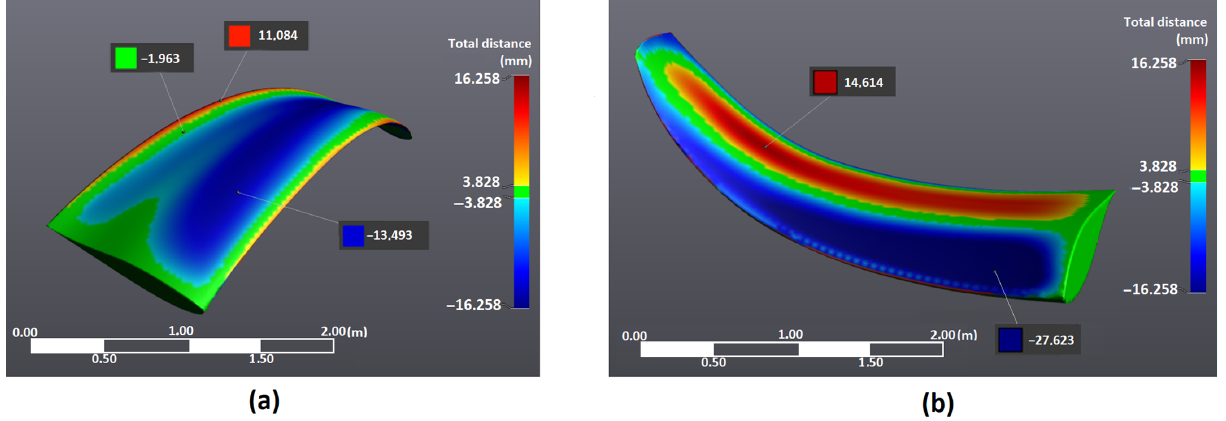
Figure 10. Bladelet dimensional deviation [mm] after shape optimization. ( a ) Lower tip side, ( b ) upper tip side.